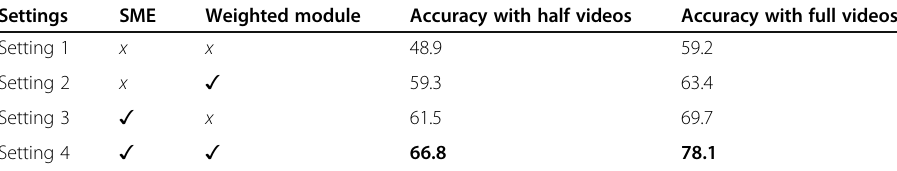
Table 5 Ablative study on sub-JHMDB dataset (%) Settings SME Weighted